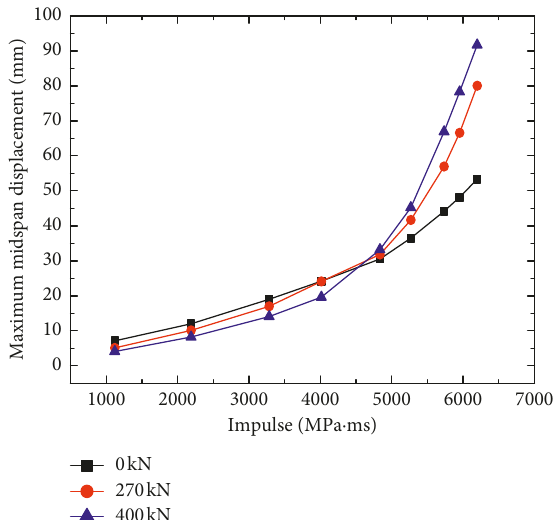
Figure 12: Effects of axial loads on the displacement responses of columns under various load